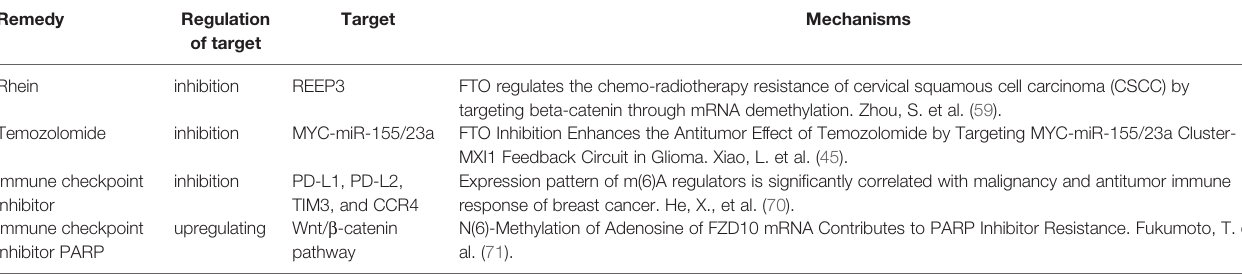
TABLE 2 | Therapeutic targets of M6A modi fi cation in common female malignant (CFM).